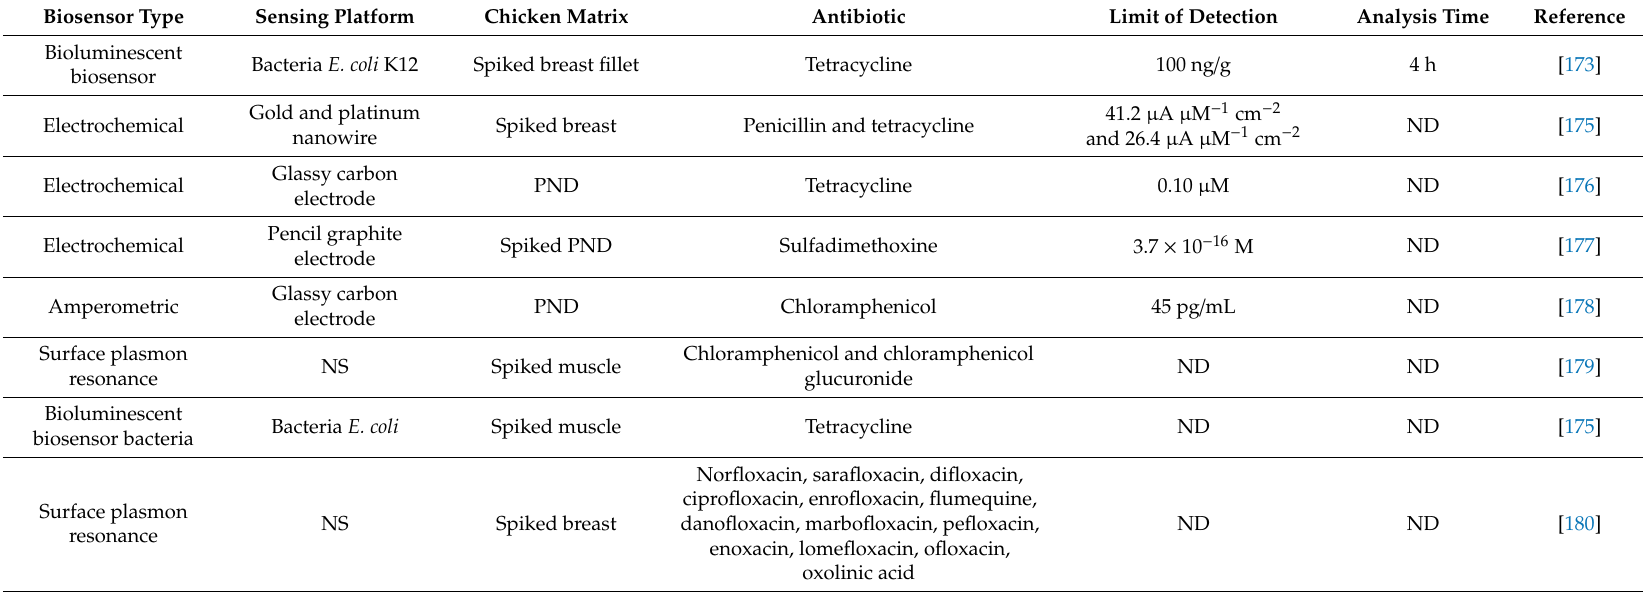
Table 13. Biosensor-based approaches used for the detection of antibiotics residue in chicken